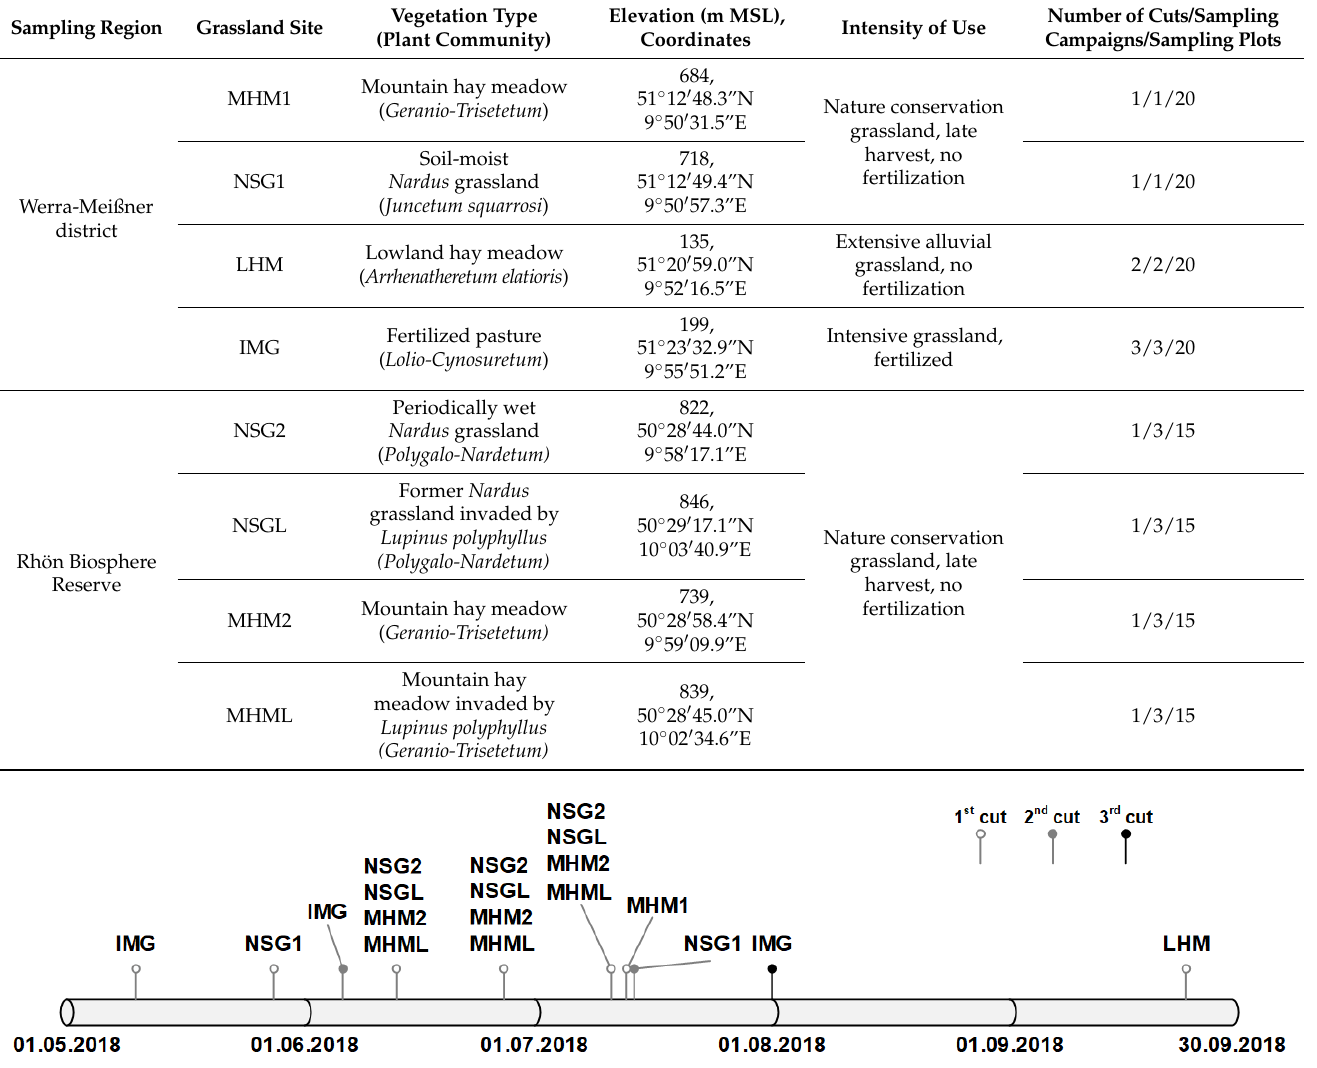
Figure 2. Biomass sampling dates at probed grassland sites. At grassland sites NGS2, NSGL, MHM2 and MHML different plot areas were cut at three sampling dates, resulting in differing dates for the 1st cut.